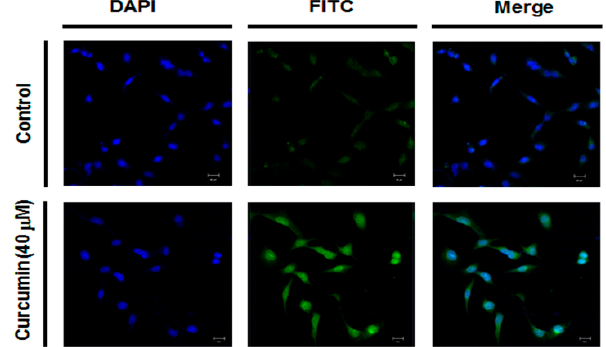
Figure 4. Immunofluorescence staining of ganglioside GD3 in A549 cells treated with curcumin. After curcumin treatment for 24 h, immunostaining using anti-GD3 antibodies (FITC; green) and DAPI staining (blue) were performed, and analyzed by confocal laser scanning microscope (200×).